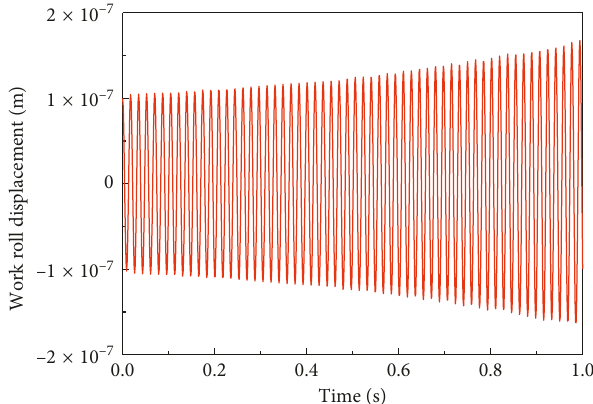
Figure 10: Work roll time history displacement under the rolling speed of